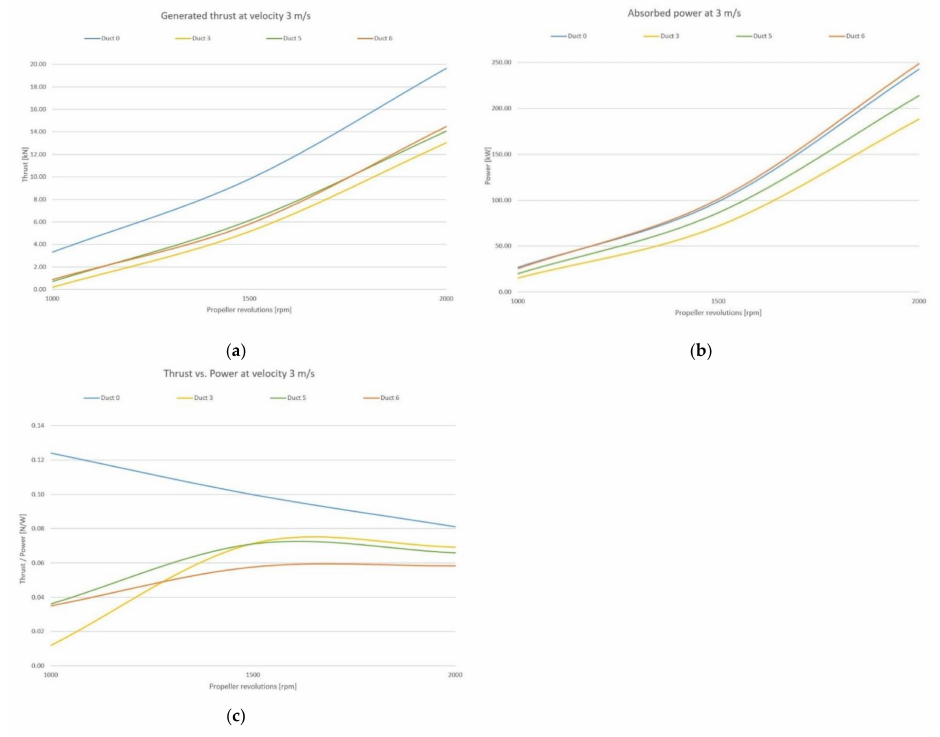
Figure 8. Comparison of parameters for flow velocity of 3 m/s. ( a ) Generated thrust at velocity 3 m/s; ( b ) absorbed power at velocity 3 m/s; ( c ) generated thrust per unit of absorbed power at the speed of 3